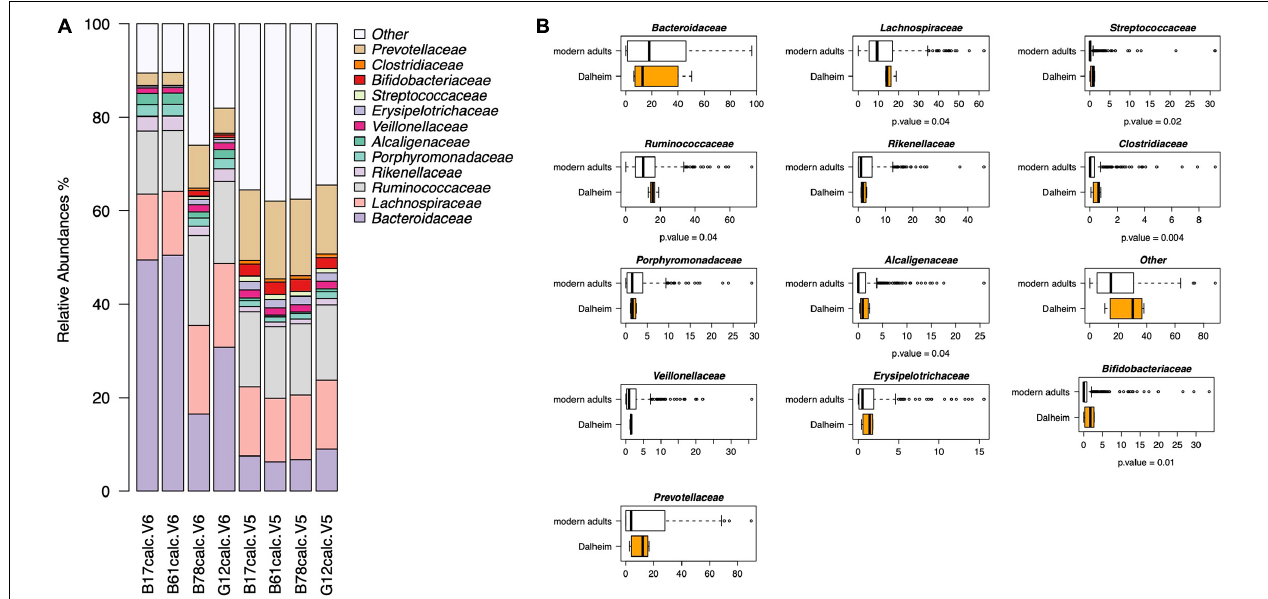
FIGURE 5 | Reconstructing the ancient stool microbiome of adult medieval individuals. (A) Bar plots of stool microbiome configurations inferred from 16S rRNA gene (V5 and V6 regions) sequencing data of ancient microbiomes (i.e., dental calculi from the medieval monastic site of Dalheim, Germany [ca. 950–1,200 CE]) (Warinner et al., 2014). (B) Comparison between the predicted ancient microbiome configurations and the modern stool microbiome of subjects from the dataset used to implement G2S (The Human Microbiome Project Consortium, 2012; Zaura et al., 2015; Brito et al., 2016; Russo et al., 2018). P -values were determined by Wilcoxon